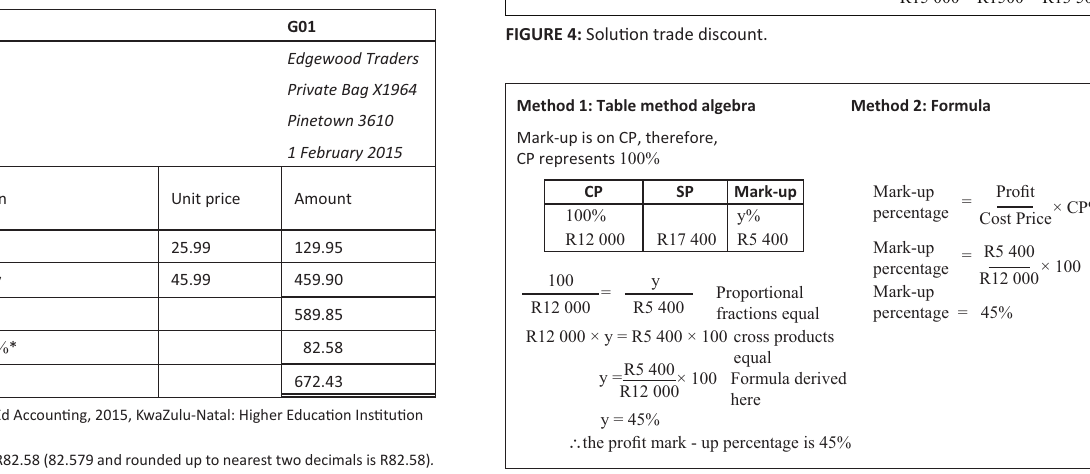
FIGURE 3: Credit invoice as an example of use of basic arithmetic operations.